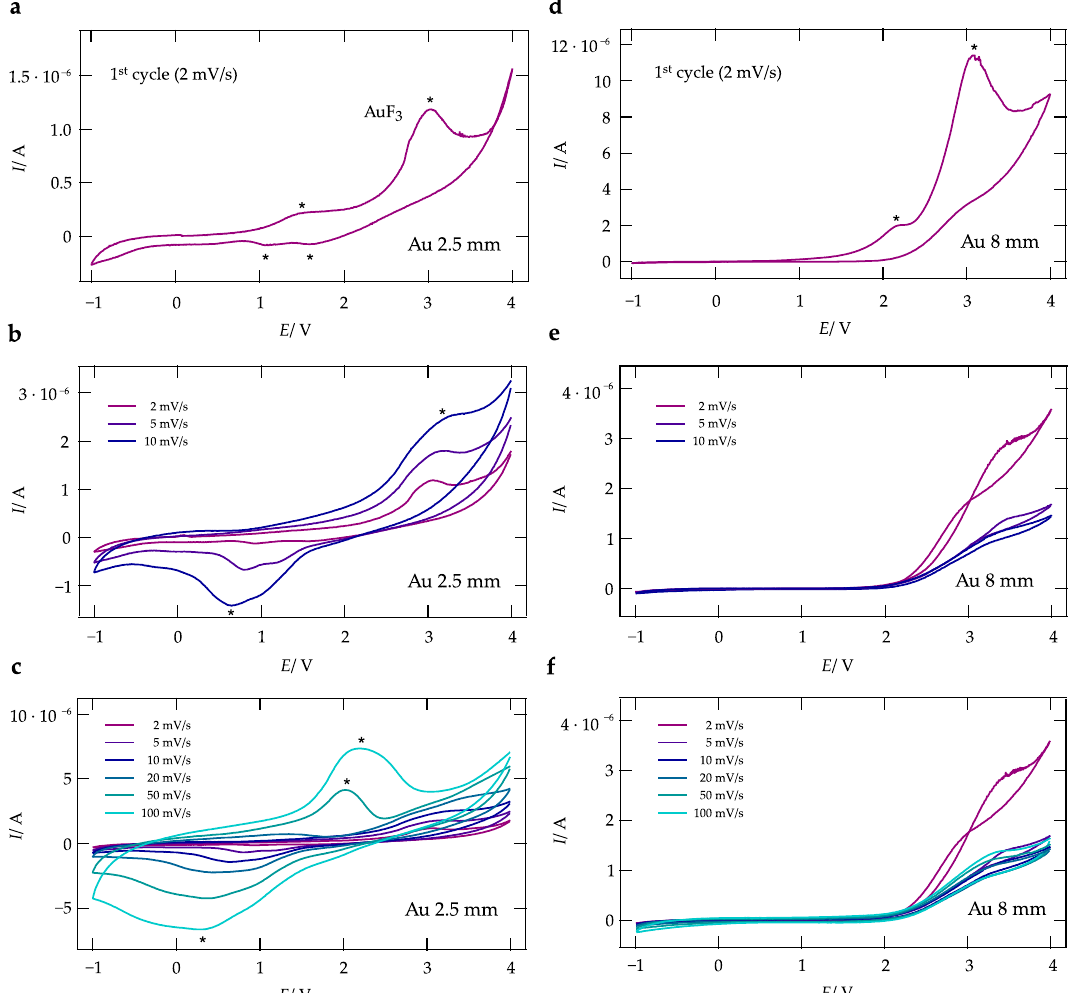
Figure 4. Cyclic voltamogram of cells with La 0.9 Ba 0.1 F 2.9 as solid electrolyte and Au working as electrode metal. The CVs were recorded at a temperature of 200 ◦ C, with scan rates ranging from 2 mV/s up to 0.1 V/s; working electrode diameters are 2.5 mm ( a – c ) and 8 mm ( d – f ). The current response of the first cycles are shown in ( a , d